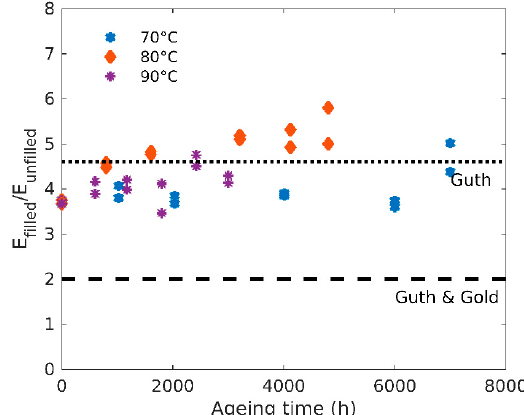
Figure 4. Ratio of the filled and unfilled moduli as a function of ageing time for three ageing temperatures.